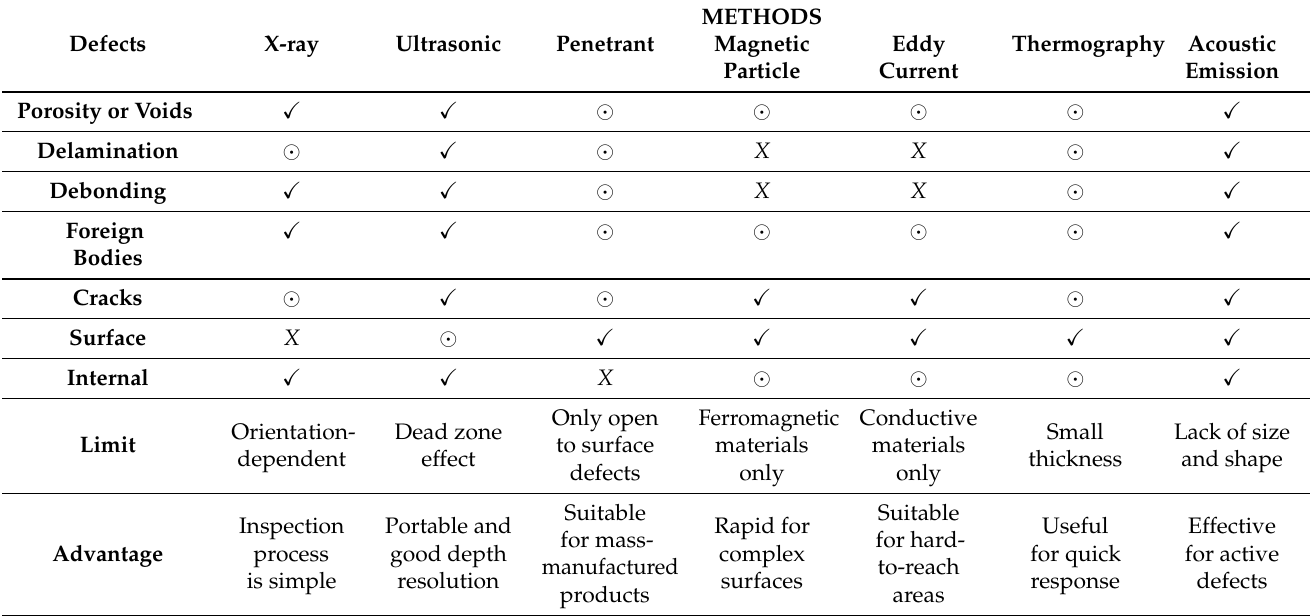
Table 1. NDT method standings relative to defect